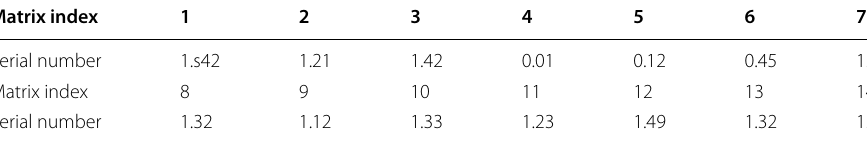
Table 2 1–14 judgment matrix